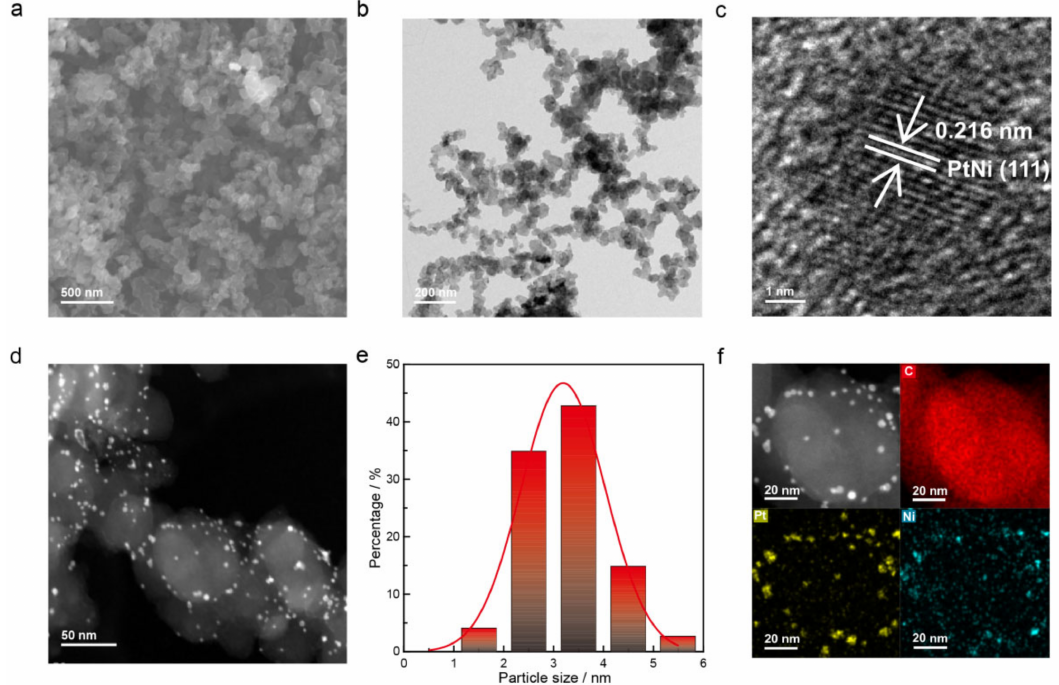
Figure 3. Structural characterization of PtNi/C-200. ( a ) SEM image, ( b ) TEM and ( c ) HRTEM images, ( d ) HAADF-STEM image, ( e ) size histogram, and ( f ) EDS elemental mapping images of PtNi/C-200.